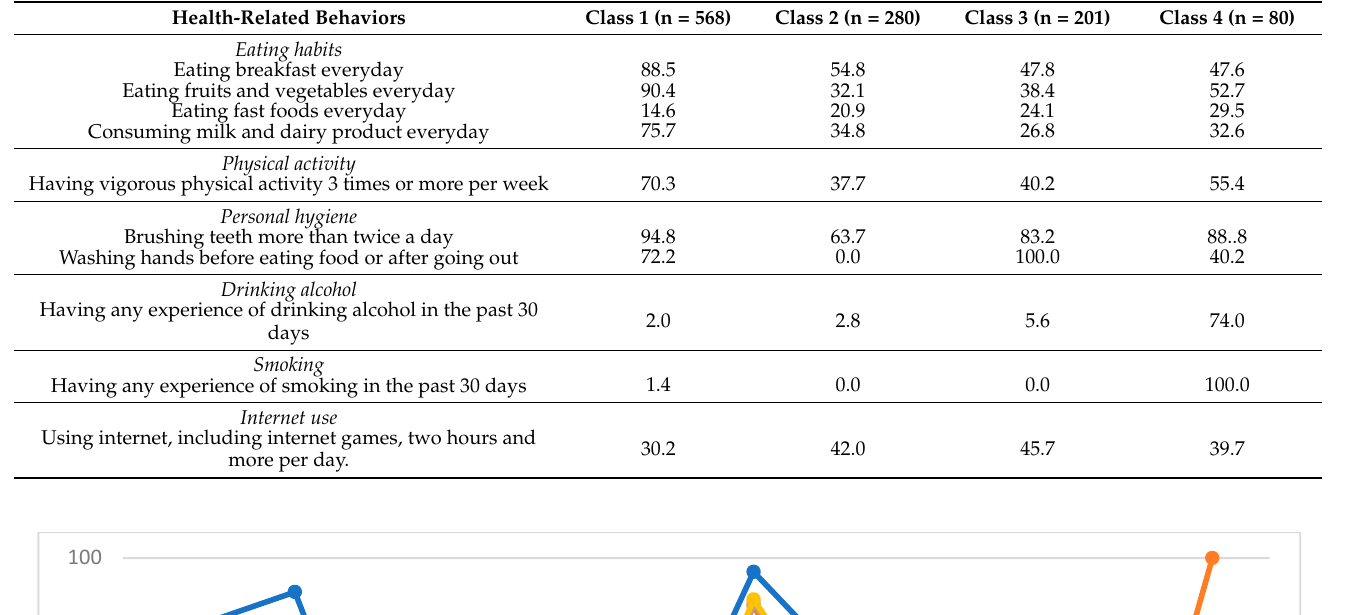
Table 2. Proportions of health-related behaviors of male adolescents by the classes (%).